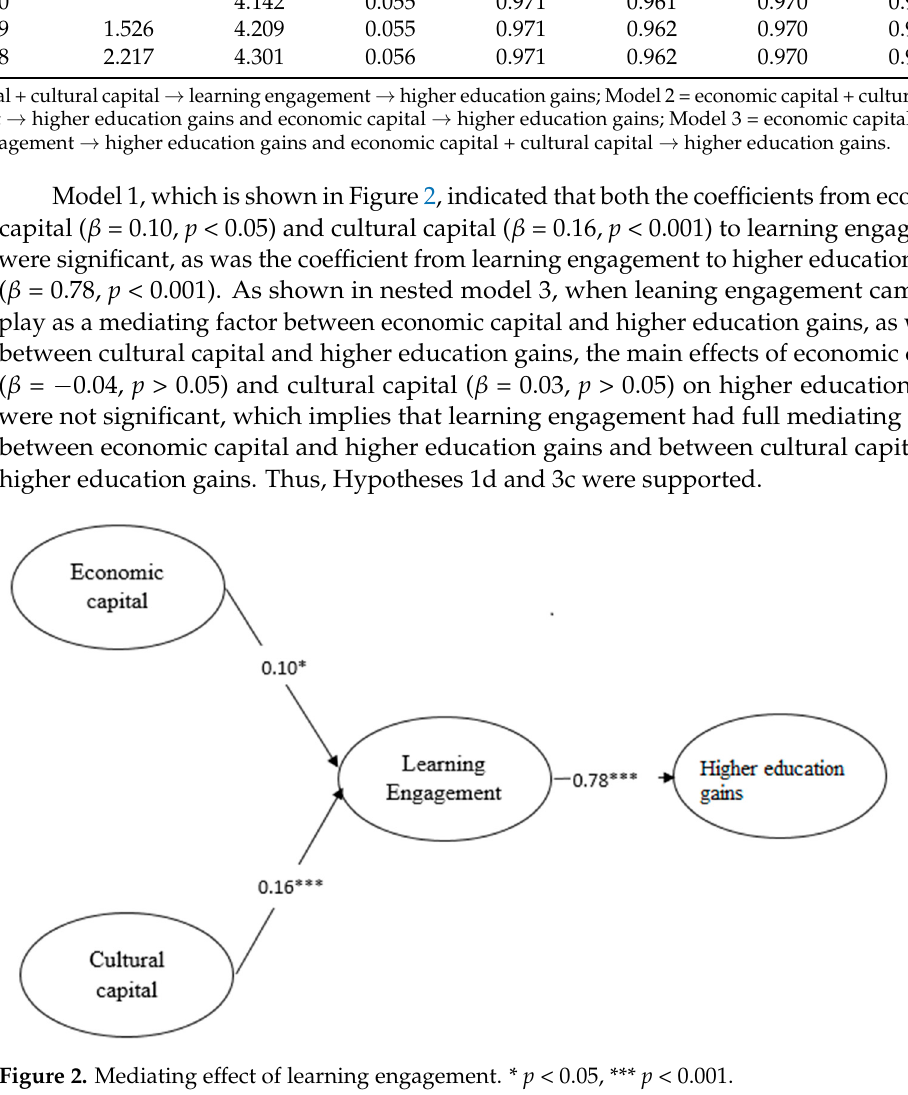
Table 3. Goodness-of-fit index.